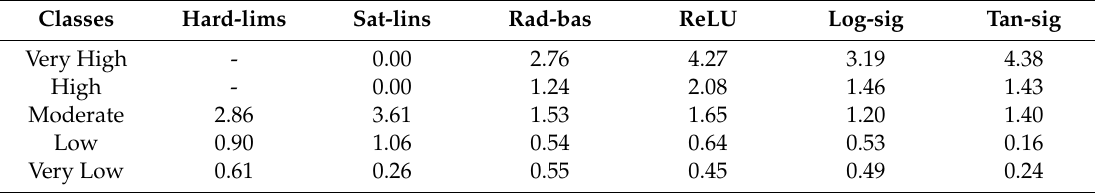
Figure 8. Landslide susceptibility maps produced using the ( a ) Hard-lims, ( b ) Sat-lins, ( c ) Rad-bas, ( d ) ReLU, ( e ) Log-sig, and ( f ) Tan-sig functions. Table 8. Landslide density according to susceptibility